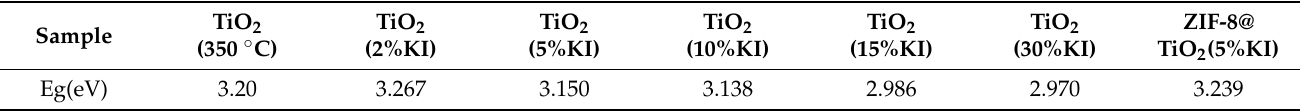
Figure 6. DRS diagram ( a ) and band gap width diagram ( b ). Table 3. Forbidden material band